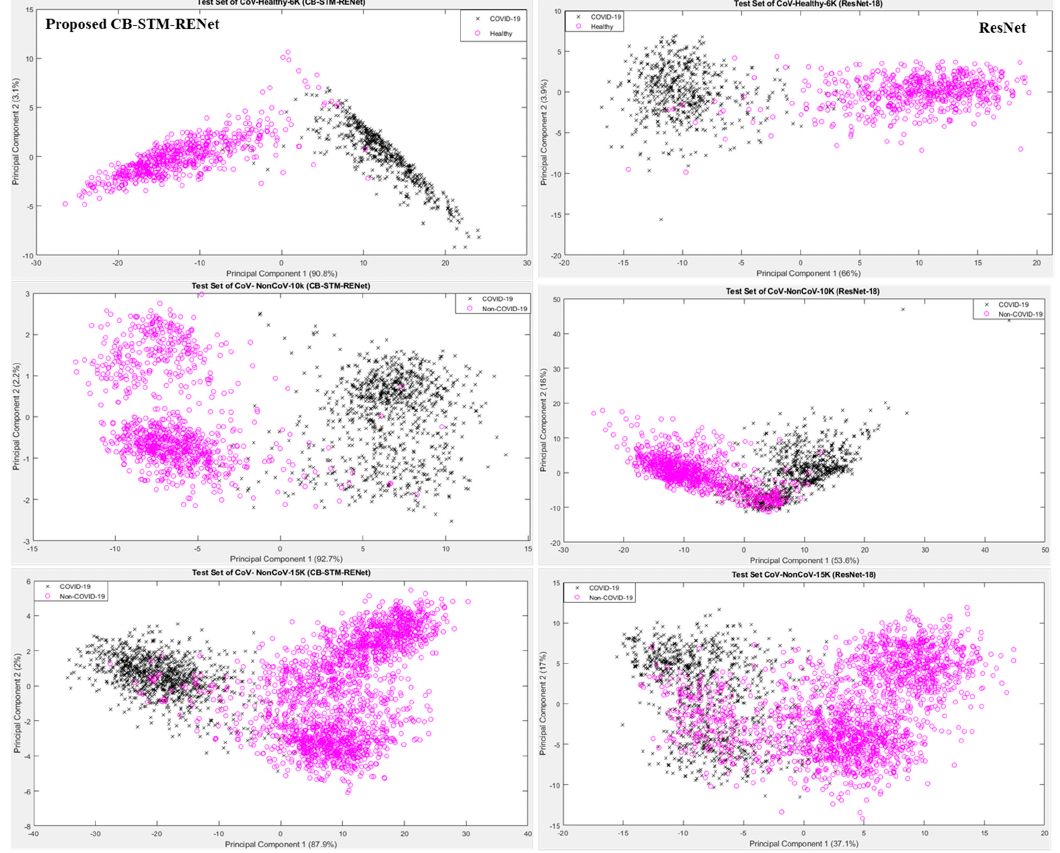
Figure 9. Feature space visualization of the proposed CB-STM-RENet and ResNet on test dataset.